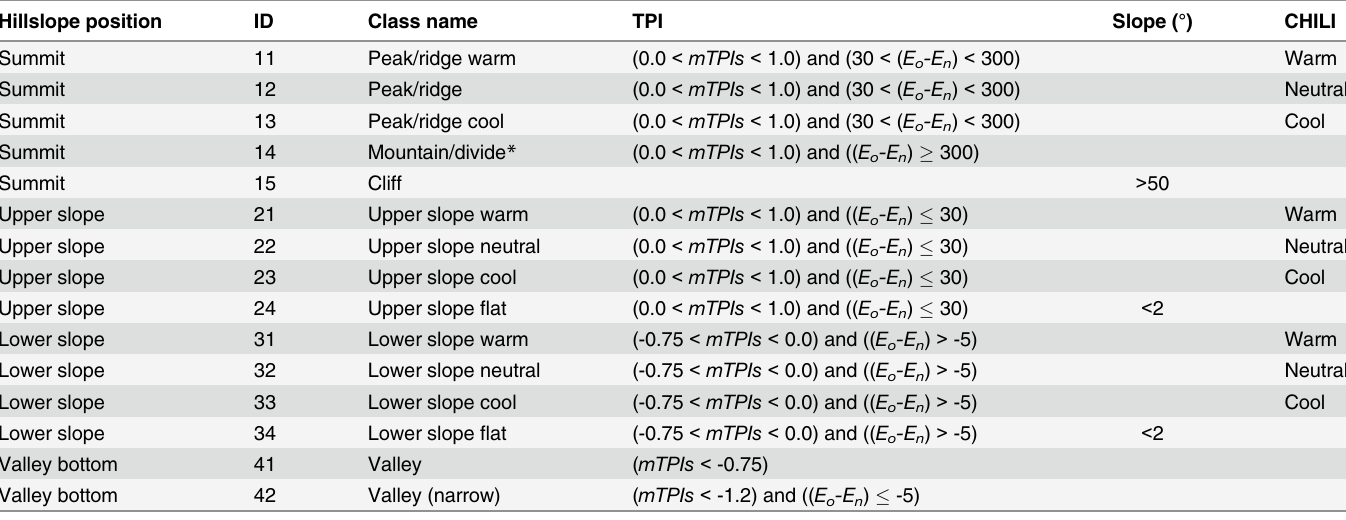
Table 1. A hierarchical classification of ecologically relevant landforms. Hillslope